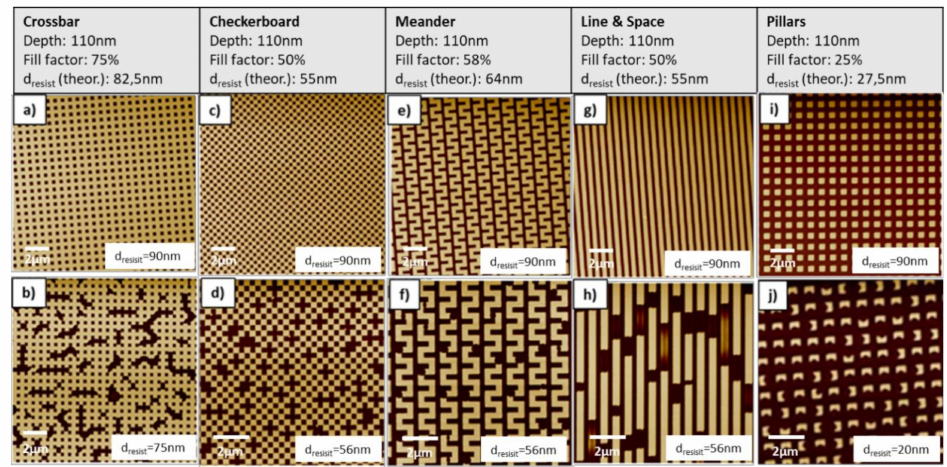
Figure 7. Top view images showing a comparison between different geometries after imprinting: ( a , b ) Crossbar, ( c , d ) checker- board, ( e , f) meanders, ( g , h ) line and space (L/S), and ( i , j ) pillars. Top row shows the fully replicated patterns using optimum resist volume. Bottom row shows the observed defects if less than optimum resist volume is used. The critical dimension for all patterns geometries was 300